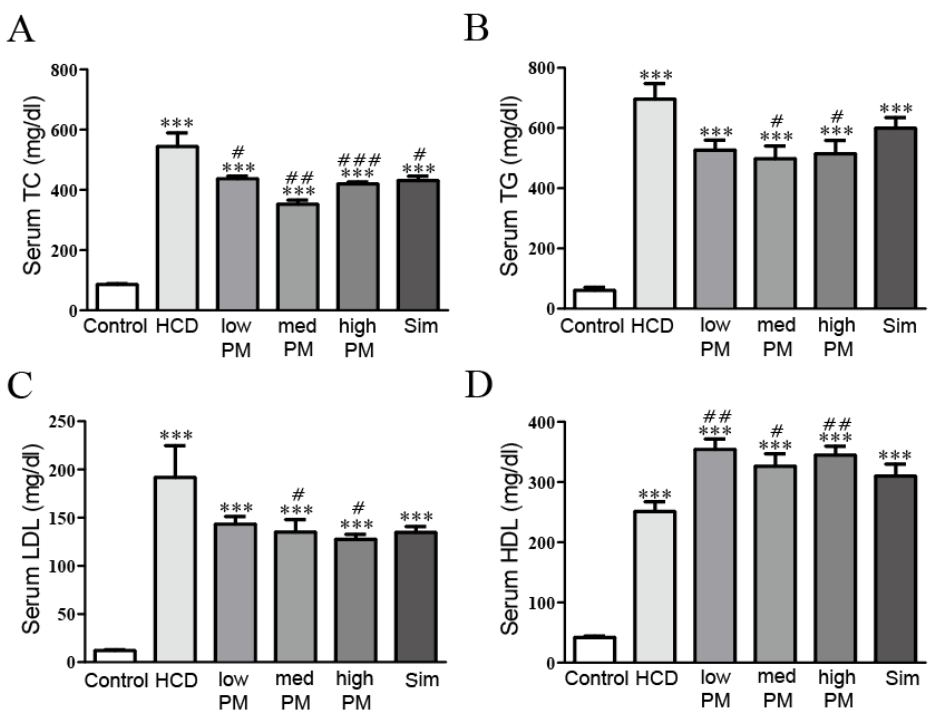
Figure 2. Effects of PM treatment on serum levels of ( A ) TC, ( B ) TG, ( C ) LDL-cholesterol, and ( D ) HDL-cholesterol in hypercholesterolemic rats. Data are expressed as mean ± SEM. Significance was measured by performing a one-way ANOVA followed by Bonferroni’s post-hoc test. *** p < 0.005 vs. control. # p < 0.05, ## p < 0.01, ### p < 0.005 vs. HCD-fed group. HCD, high cholesterol diet-fed group; low-, med-, and high-PM: low (1.65 × 10 9 cfu/kg/day), medium (5.5E × 10 9 cfu/kg/day), and high doses (1.65 × 10 10 cfu/kg/day) of probiotic mixture-treated group, respectively; Sim, simvastatin-treated group; TC, total cholesterol; TG, triglycerides; LDL, low-density lipoprotein cholesterol; HDL, high-density lipoprotein